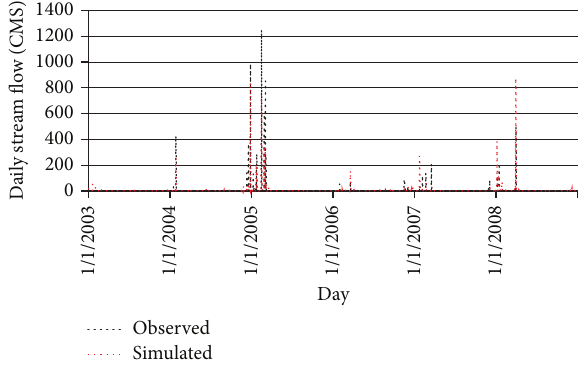
Figure 5: Measured and simulated stream flow (CMS) for test